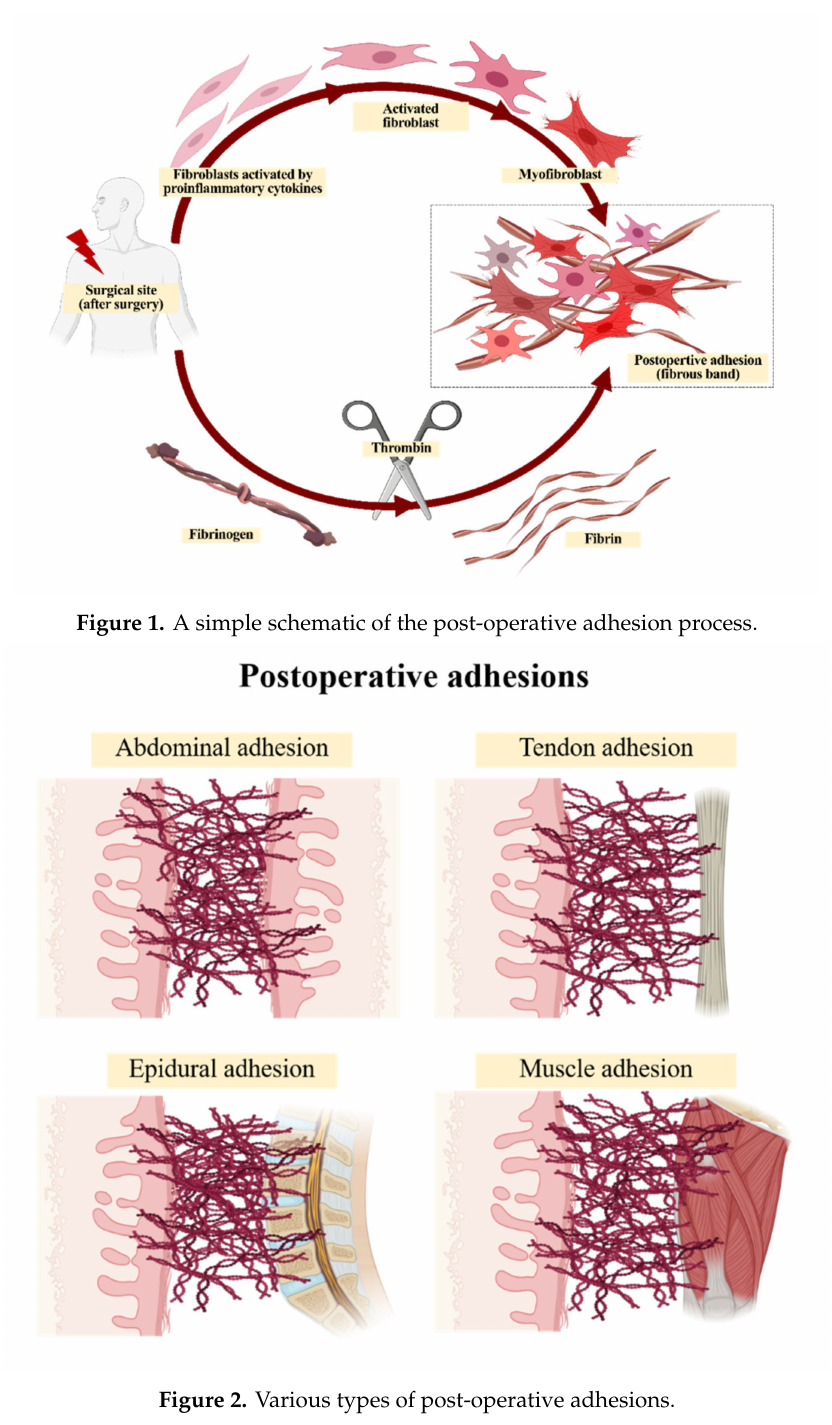
Figure 2. Various types of post-operative